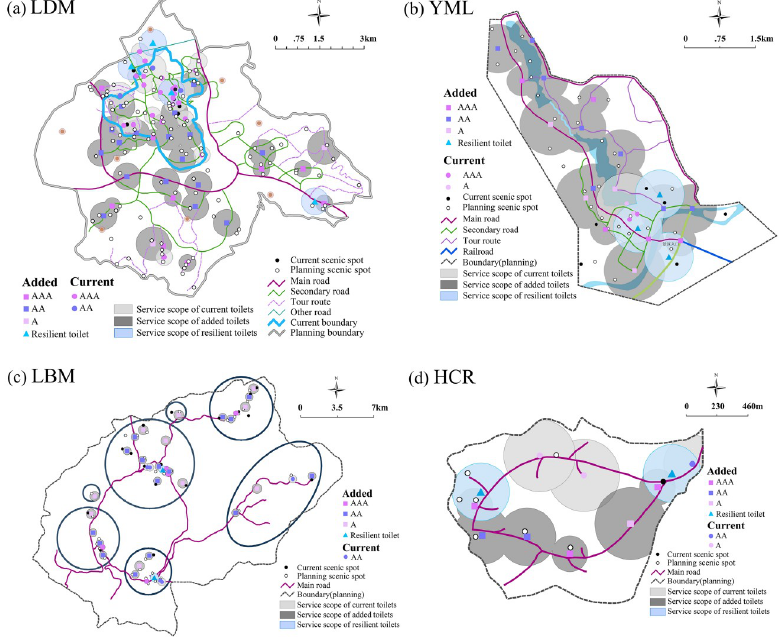
Fig 10. Optimal layout schemes for tourist toilets in scenic areas (copyright hold by the